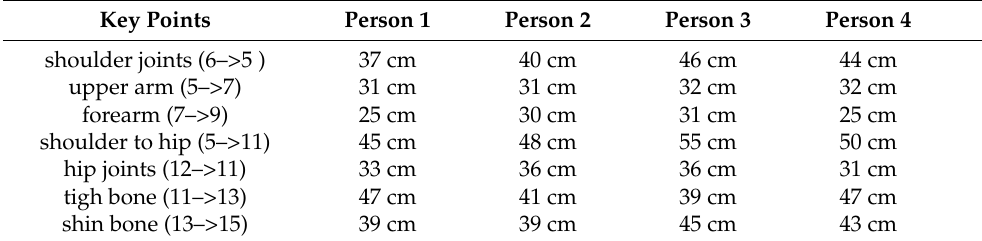
Table 1. Automatic measurements of the keypoints.